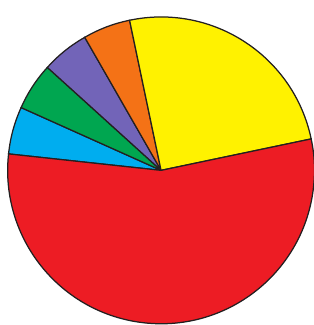
Fig. 1. 3D flat pie chart defined by SLD